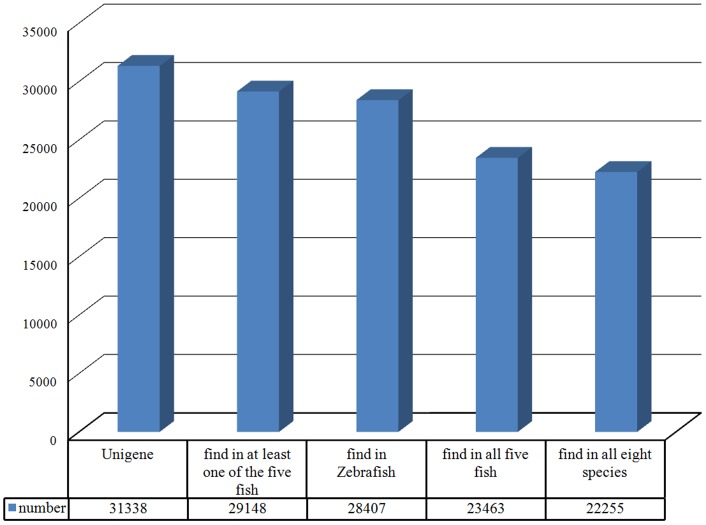
Genes conserved in blunt snout bream and five model fish species (zebrafish, medaka, Tetraodon, fugu, and stickleback), humans, mice, and chickens.Unigenes of the blunt snout bream were characterized by searching against public databases. The number of blunt snout bream homologous genes identified in other species by using BLASTX.